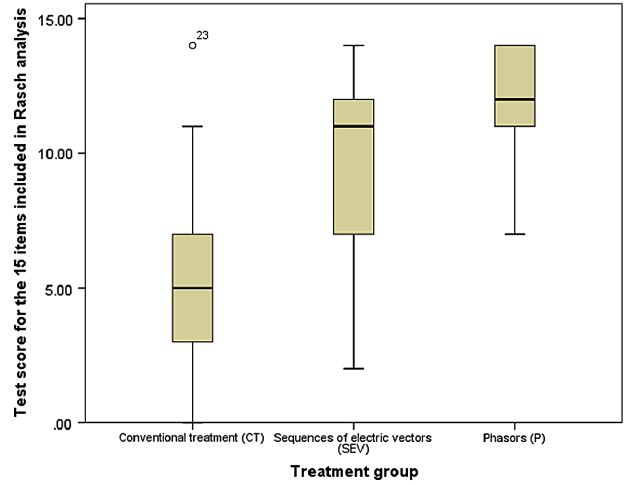
FIG. 5. Box plots that describe the distribution of test scores across comparison groups. Theoretically, the test-score scale ranges from 0 to 15 points. Circles represent outliers.